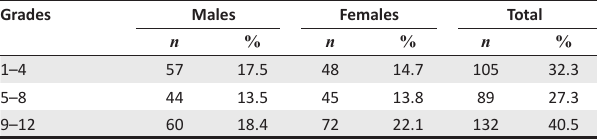
TABLE 3: Distribution of participants according to grade. Grades